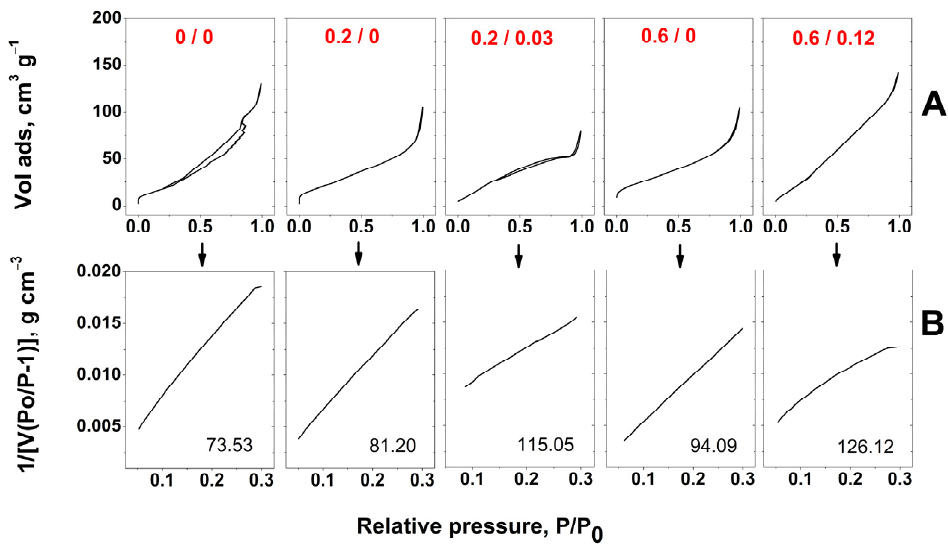
Figure 7. Full nitrogen adsorption isotherms ( A ) and corresponding BET plots including BET sur- face area (m 2 g − 1 ) ( B ) on the aerogels modified with PAMAM/CNTs (mg mL − 1 ). area (m 2 g − 1 ) ( B ) on the aerogels modified with PAMAM/CNTs (mg mL − 1 ).